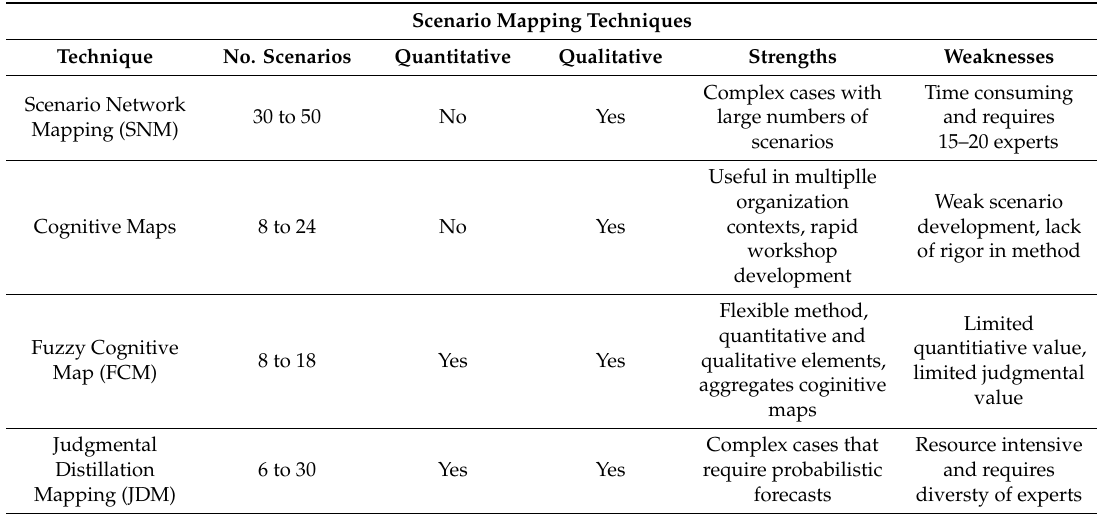
Table 2. A comparison of scenario mapping